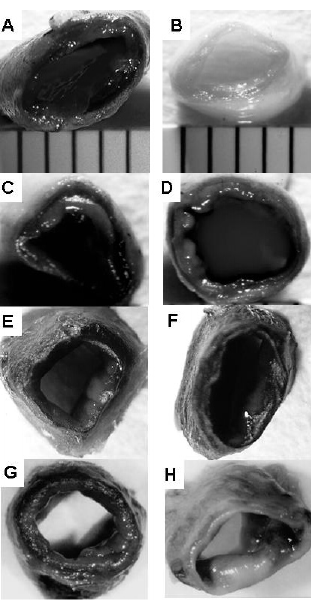
Figure 5 - MTT stain of human saphenous vein cultured in the ex vivo perfusion system. The segments were cultured under venous (C, E, G) and arterial (D, F, H) hemodynamic conditions for 1 (C, D) , 2 (E, F) or 4 (G, H) days. The freshly excised tissue (A) and dead samples (B) were used as positive and negative controls for the visualization of tissue viability. 1.5X magnification